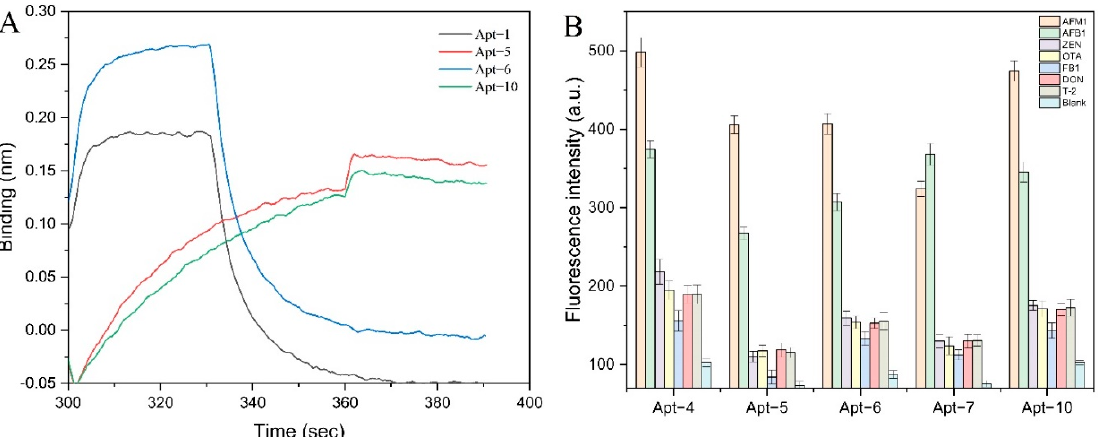
Figure 2. ( A ) The result of BLI determining the affinity of the aptamers. ( B ) Specific characterization of